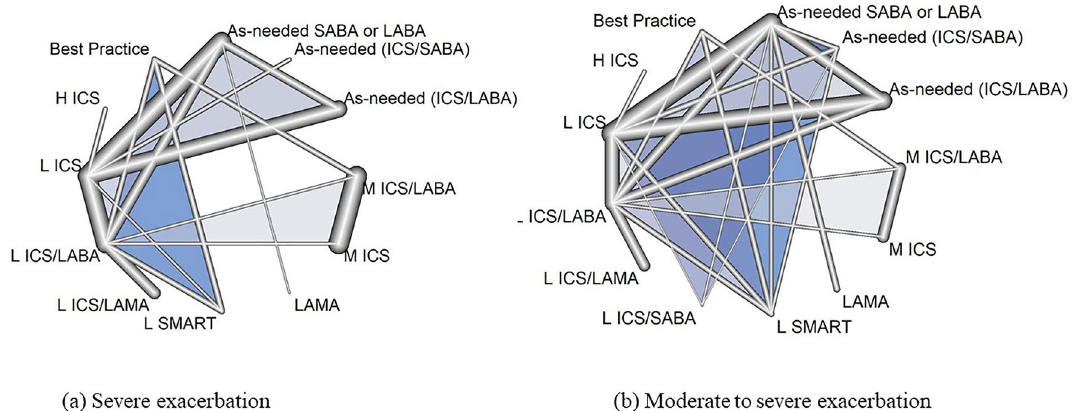
Figure 2. Network of inhaler therapies on the outcomes. The thickness of the network lines indicates the number of comparisons between each inhaler therapy. H ICS high-dose ICS, M ICS medium-dose ICS, L ICS low-dose ICS, L ICS/LABA low-dose ICS dose with LABA as maintenance, M ICS/LABA medium-dose ICS with LABA as maintenance, L SMART low-dose ICS with LABA as maintenance and reliever, L ICS/LAMA low-dose ICS with LAMA as maintenance, L ICS/SABA low-dose ICS with SABA as maintenance; best practice, adjustable dose of inhaler based on